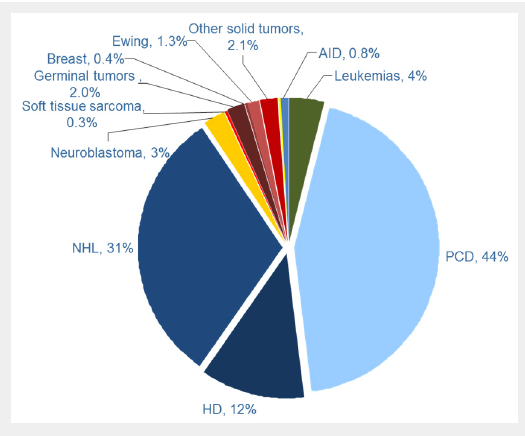
Indications for autologous HSCT in Europe in 2010 (reprinted from: Passweg JR, Baldomero H, Gratwohl A, Bregni M, Cesaro